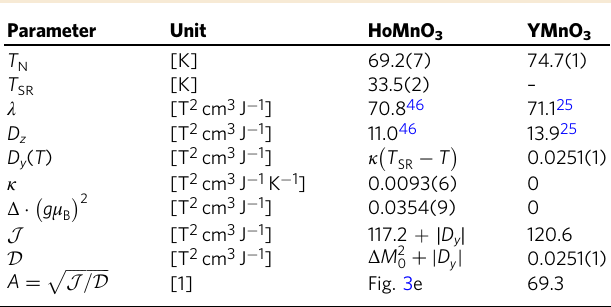
Table 1 Fit parameters. Values for λ ¼ J K z were calculated from the exchange interaction J N g μ B ð Þ 2